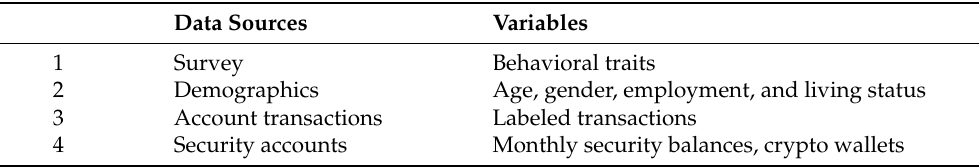
Figure 1. Number of cases of non-invested individuals, individuals invested in conventional assets, in cryptocurrencies. Source: Own data. Table 1. Different data sources received from the cooperating company. Source: Own data. Data